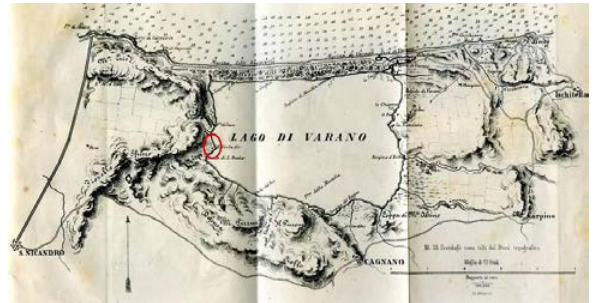
Figure 1. Cartography of the area (late 1800 c.a)